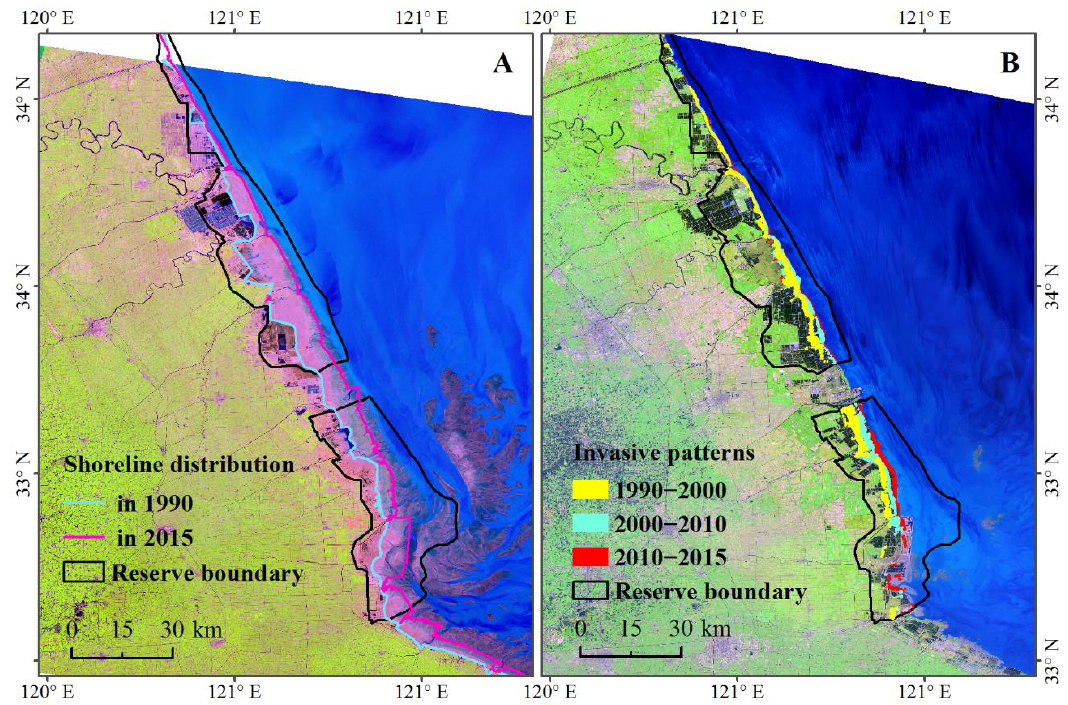
Figure 7. Change in shoreline ( A ) and invasive patterns of S. alterniflora ( B ) from 1990 to 2015 in Yancheng Ramsar site; the Landsat Thematic Mapper (TM) image (A) was obtained in 1990, while Landsat Operational Land Imager (OLI) image (B) was obtained in 2015.